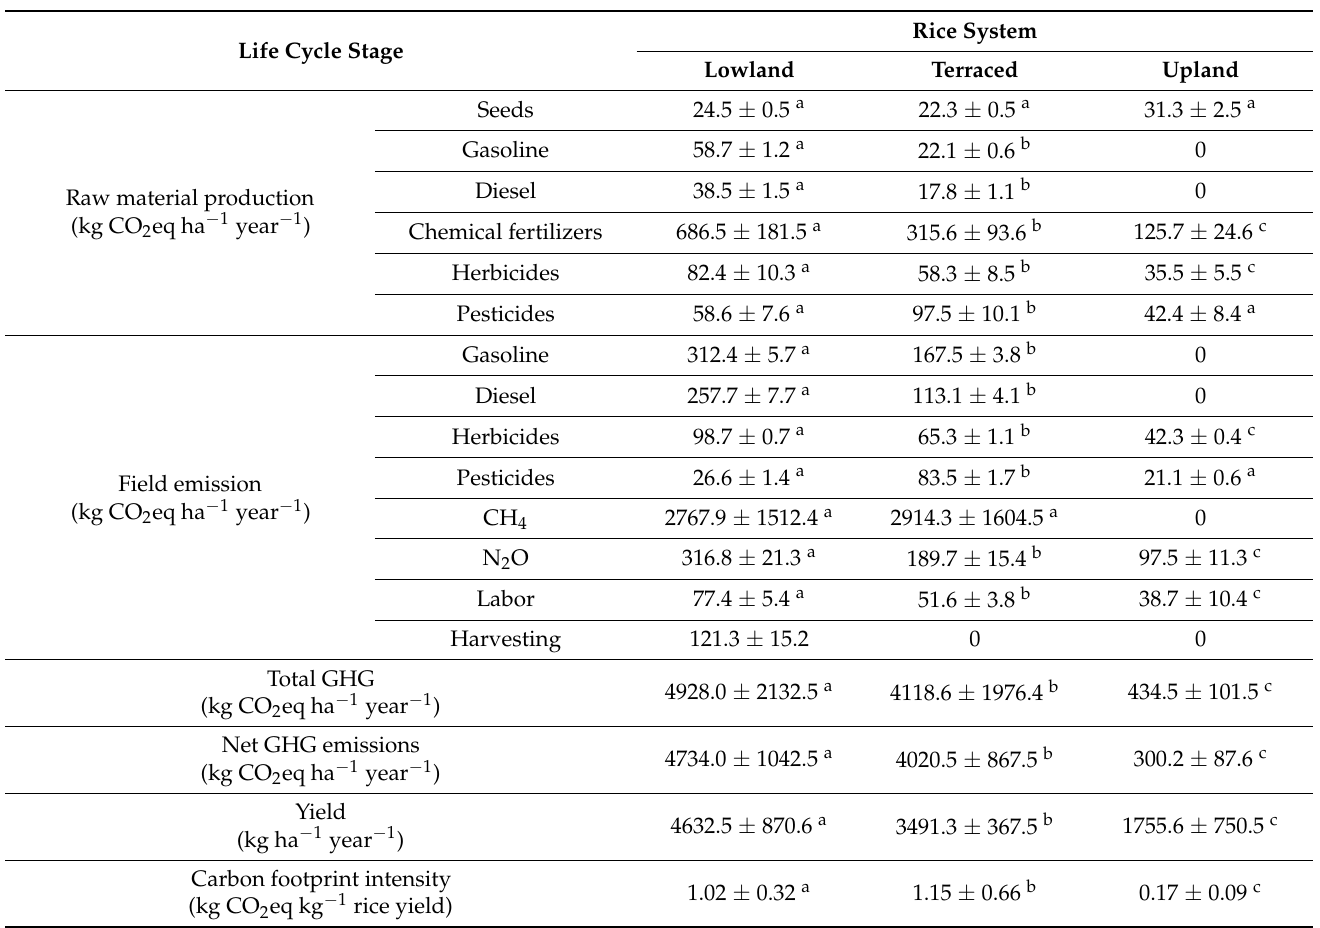
Table 3. GHG emissions of lowland, terraced, and upland rice systems during 2020–2022 (mean ± standard deviation).